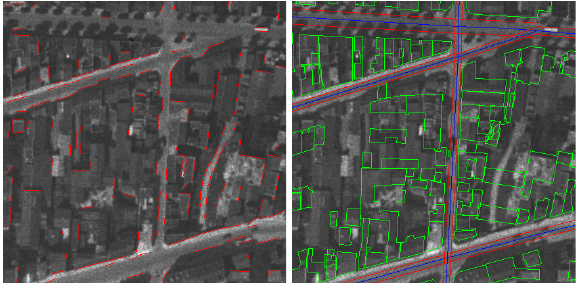
Figure 4. Illustration of pavement detection difficulty Left : detected lines in image with LSD algorithm, most of them lie on building shadows or along buildings Right : projection of TopoDB on the image (road axis are in blue, pavements are in red,and buildings are in green). Pavements are a little lighter than streets and barely